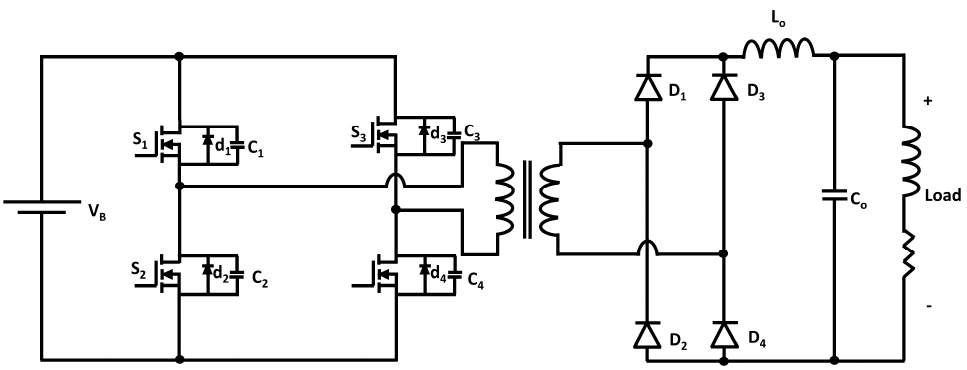
Figure 2. Isolated full-bridge phase shift